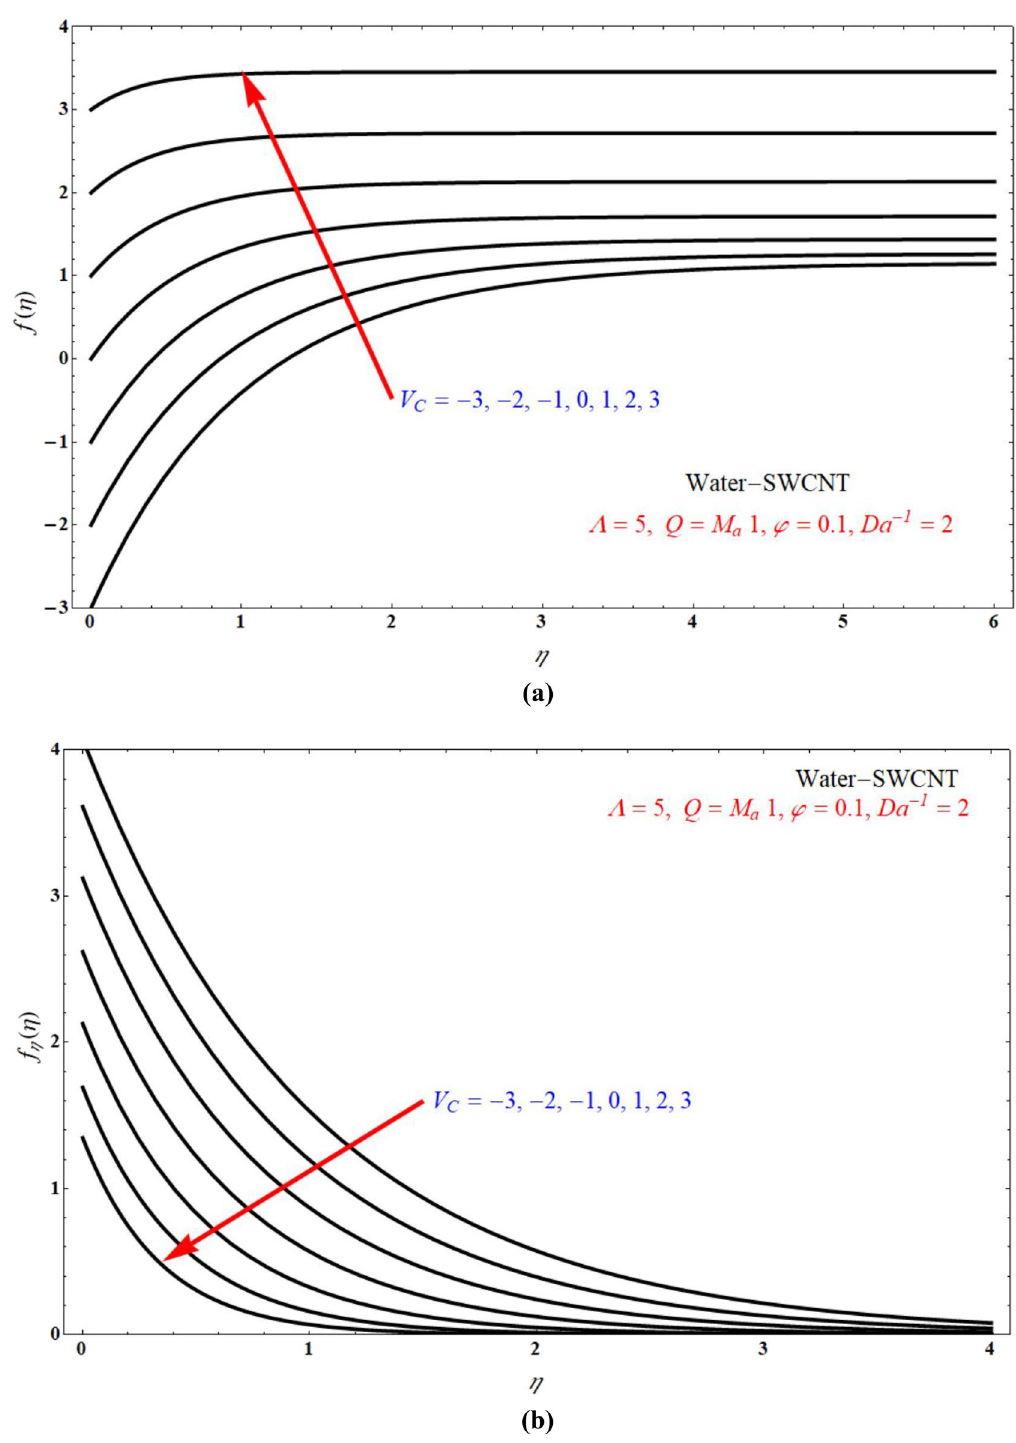
Figure 10. The plots of ( a ) f (η) verses η and ( b ) f η (η) verses η for different choices of V C